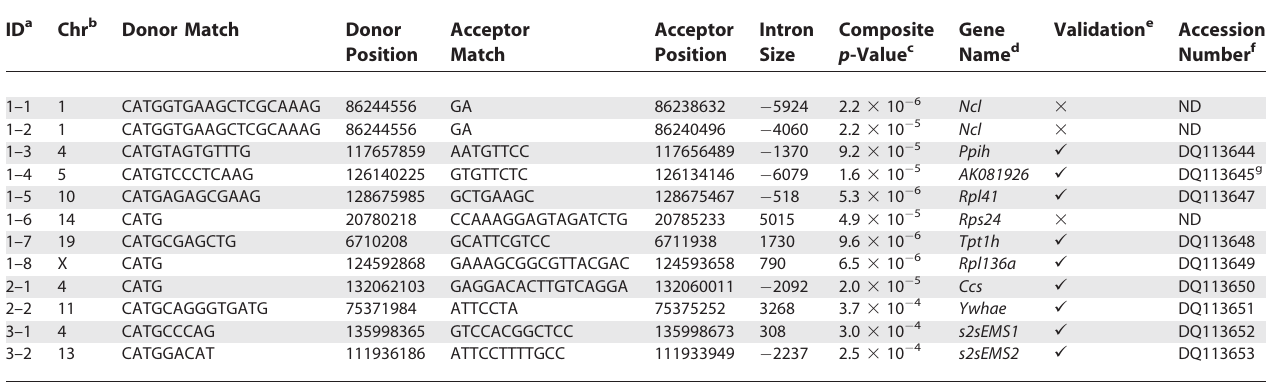
Table 2. Twelve Candidates Were Selected for RT-PCR Validation ID a Chr b Donor